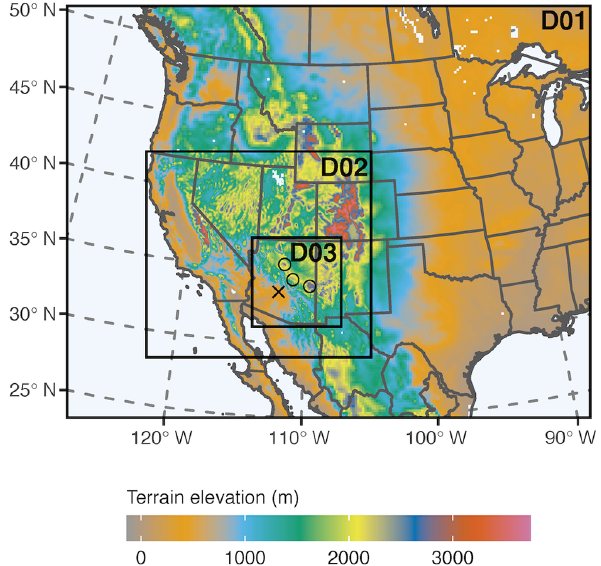
Figure 2. Telescoping model domains with shading showing terrain elevation in meters. The black × marks the location of Phoenix, Arizona. The elevated terrain feature northeast of Phoenix marked by a line of hollow circles is the Mogollon Rim.